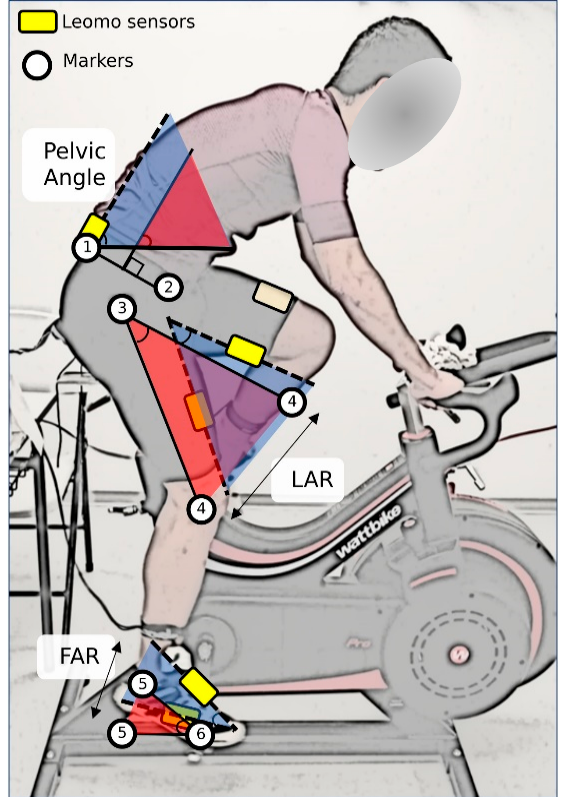
Figure 2. Conventions used for lower-extremity angles. White circle: retroreflective markers; yellow squares: Leomo sensors; 1: posterior superior iliac spine marker (PSIS); 2: anterior superior iliac spine marker (ASIS); 3: greater trochanter marker; 4: femoral condyle marker; 5: lateral malleolus marker; 6: 5th meta-tarsal head marker; LAR: Leg Angular Range; FAR: Foot Angular Range. Blue shadow represents the angular range measured by Leomo system; red shadow represents the angular range measured by Optitrack system.